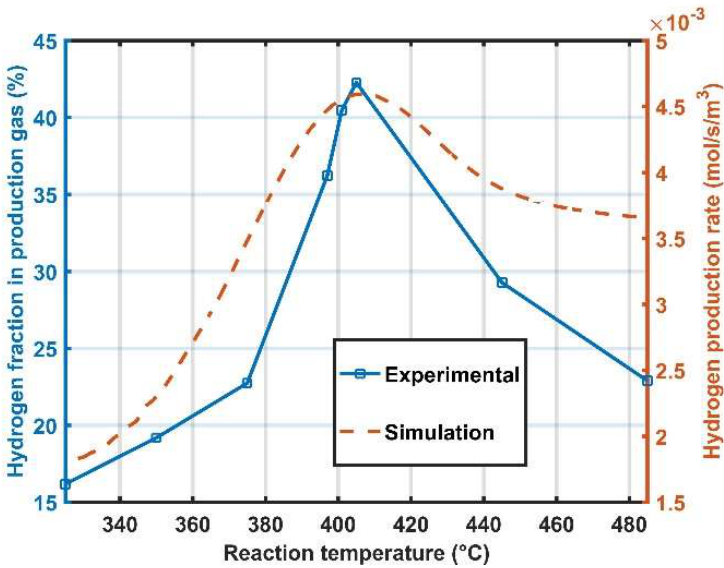
Figure 5. Schematic diagram of the hydrogen volume fraction under temperature variation.